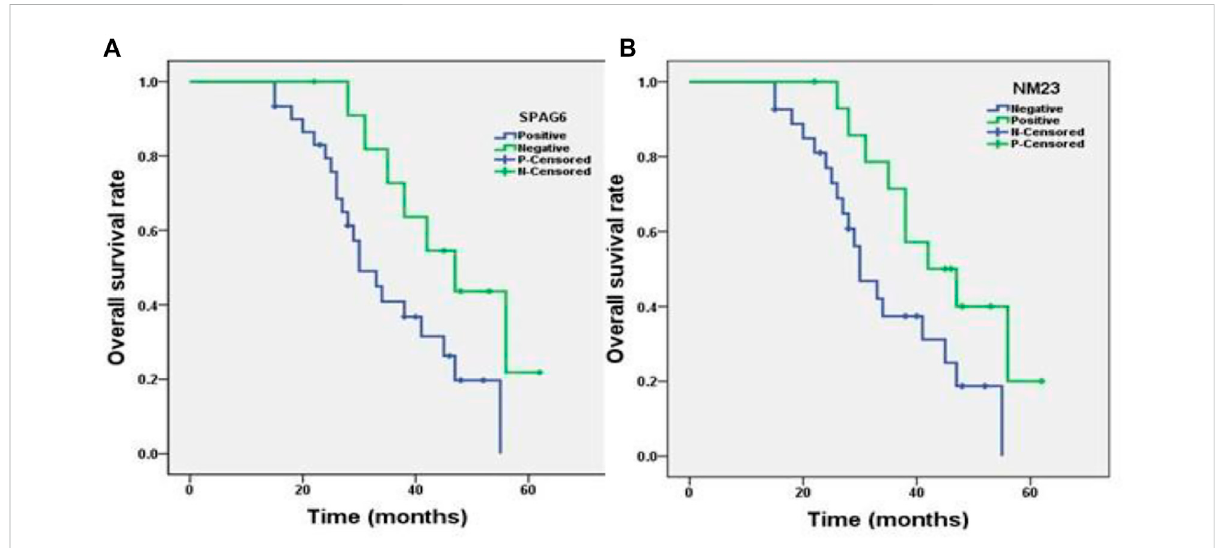
FIGURE 3 Kaplan − Meier survival analysis of patients with osteosarcoma ( n = 42). (A) Correlation of the SPAG6 protein expression level with the overall survival time of patients with osteosarcoma. The y-axis represents the percentage of patients, the x-axis represents their survival in months, and the green line represents SPAG6 + patients with a worse survival trend than the blue line representing SPAG6 - ( p < 0.05). (B) Correlation of the NM23proteinexpression levelwiththeoverall survivaltime ofpatients withosteosarcoma,and thegreenline representsNM23 + patientswitha better survival trend than the blue line representing NM23 - patients ( p < 0.05).